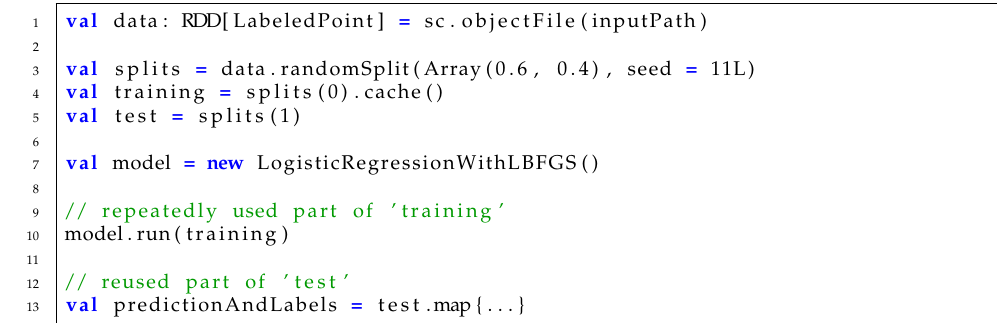
Figure 1. Source code of logistic regression on